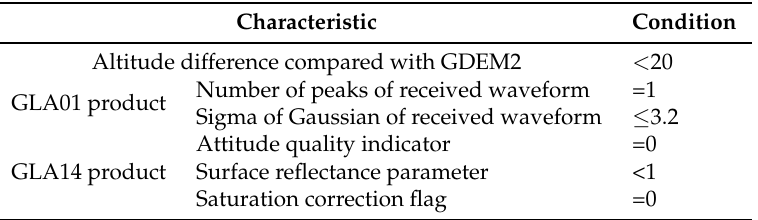
Table 2. The criterion for Geoscience Laser Altimeter System (GLAS) footprint